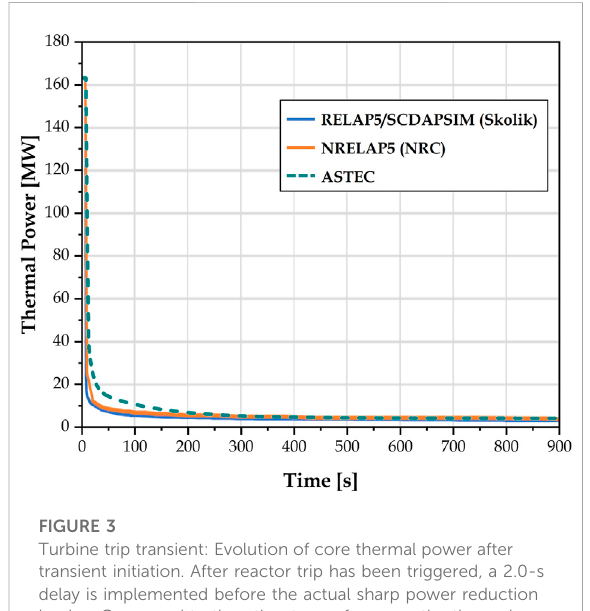
TABLE 6 Sequence of events in the turbine trip transient simulated. The initiating event occurs at time t = 0.0 s, causing a rise in